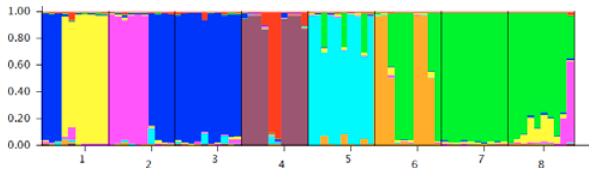
Figure 7. STRUCTURE plot of Z. Jujube populations based on k = 8.